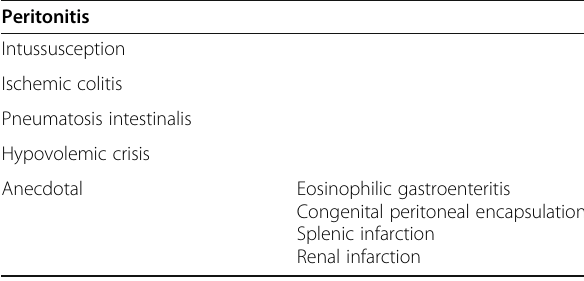
Table 2 Causes of acute abdominal pain in nephrotic patients